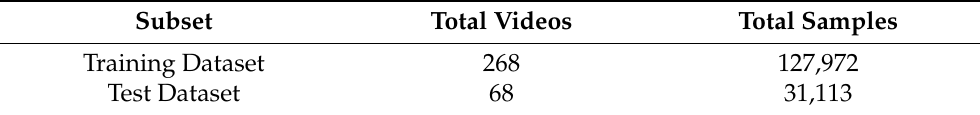
Table 3. Training-test